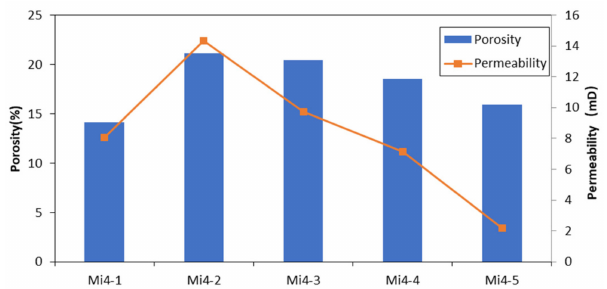
Figure 9. The average porosity and permeability of the Mi4